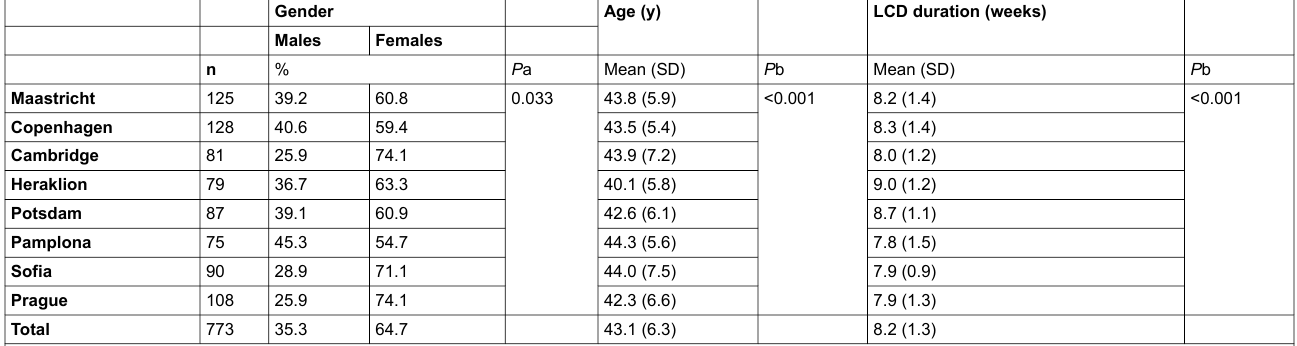
Table 1: Distribution of gender, participant age and LCD duration in the DiOGenes participating cities ( n 773), 2006–2007.